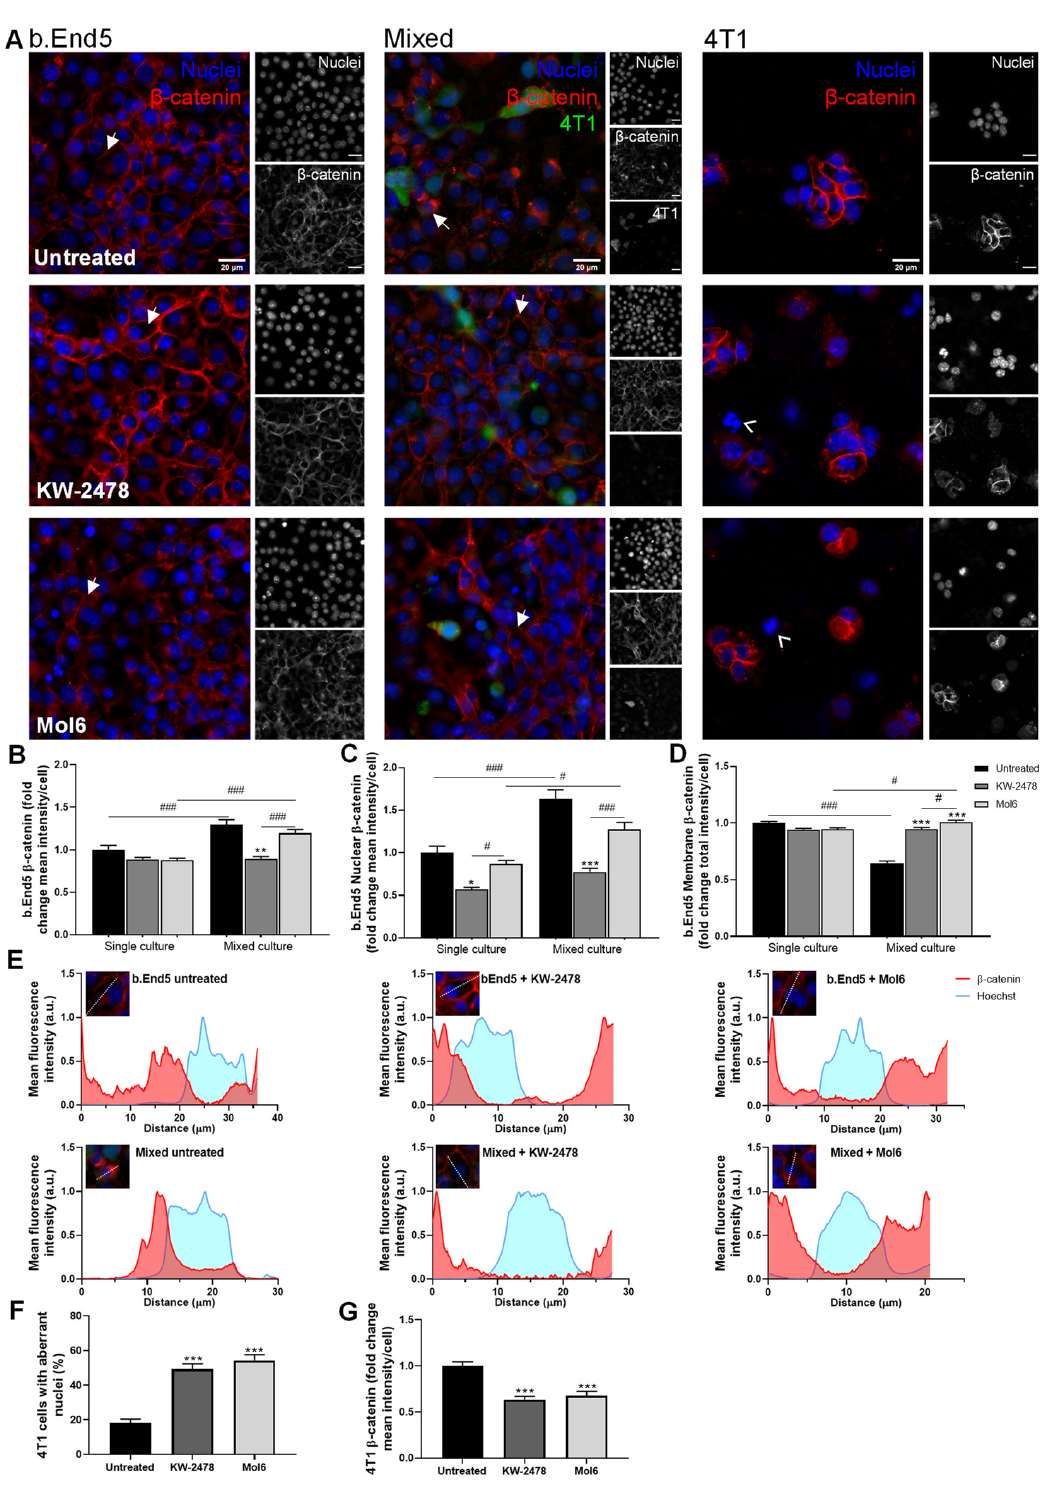
Figure 3. KW-2478 and Mol6 enhance barrier properties through increased membrane β -catenin expression in b.End5 cells exposed to 4T1 cells. Confluent monolayers of b.End5 cells under physi- ological laminar non-pulsatile shear stress were exposed to 4T1 cells (previously labelled with CellTracker™ CMFDA Green Dye,) and treated with KW-2478 or Mol6 (1 µM), or DMEM (un- treated), for 24 h and the expression of the AJs protein β -catenin (red), in single and mixed cultures, was evaluated by immunofluorescence analysis. Hoechst 33342 was used as counterstaining for nu- clei (blue). Scale bar: 20 µm. ( A ) Treatment with KW-2478 and Mol6 induced an increase in β -catenin expression in endothelial cells exposed to 4T1 cells, particularly at cell membrane (white arrows), and an increase in 4T1 cells with aberrant nuclei (white arrow heads). Semi-quantitative analysis of endothelial β -catenin ( B ) mean intensity per cell, ( C ) nuclear intensity, and ( D ) membrane intensity confirmed the observations. ( E )The localisation of β -catenin was studied through plot profiles of